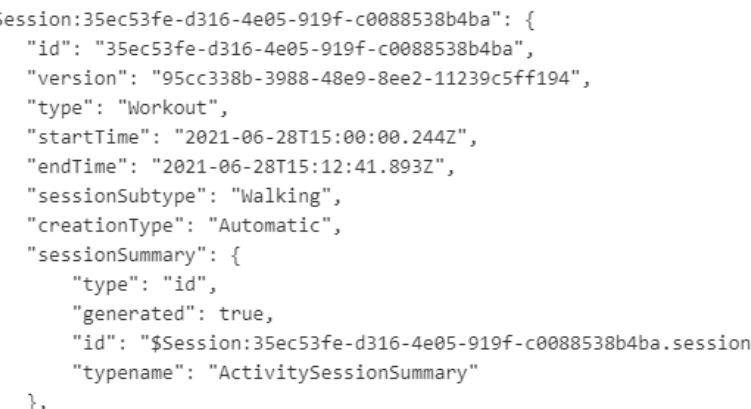
Figure 6. Session generated when the Amazon Halo device automatically detected that the user did a